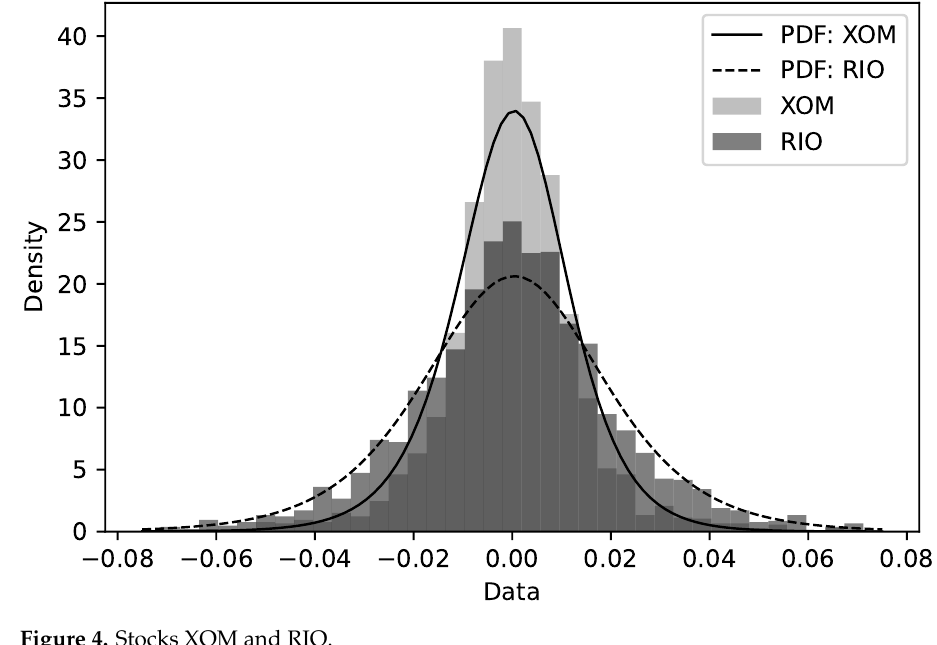
Figure 4. Stocks XOM and RIO.